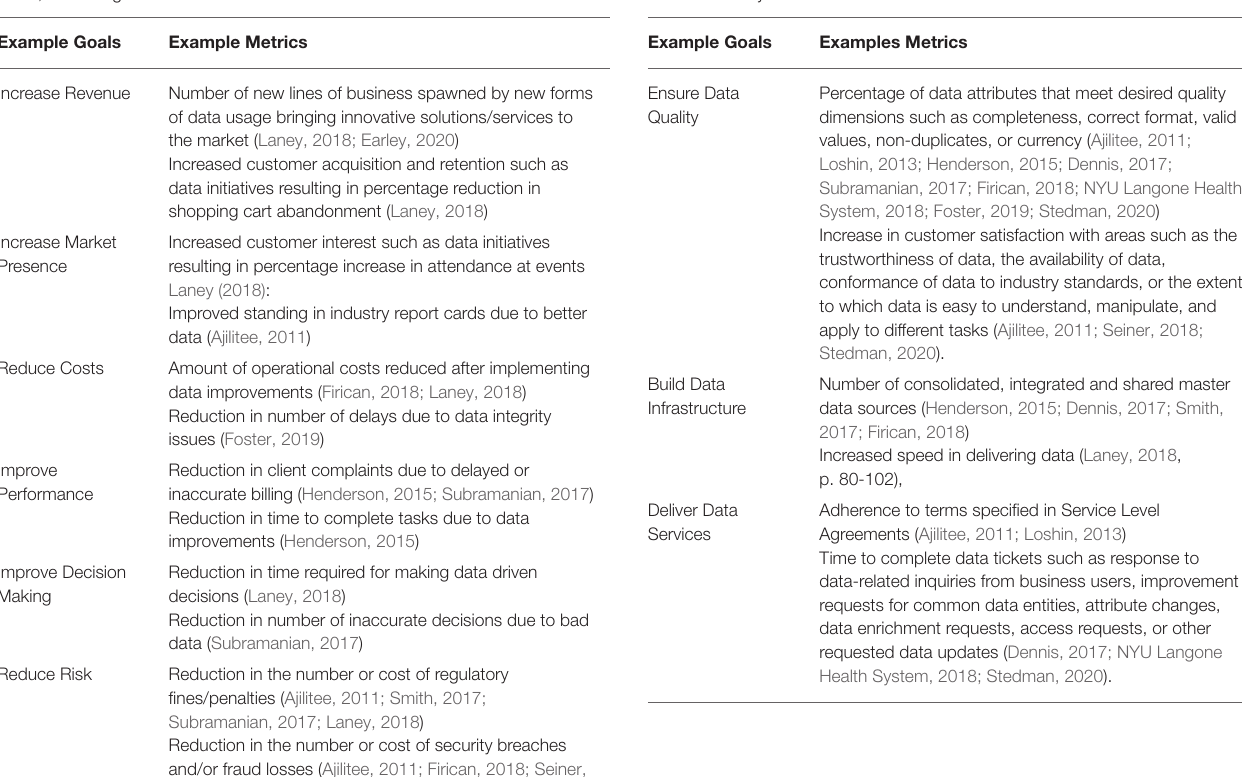
TABLE 4 | Data consumer example goals and